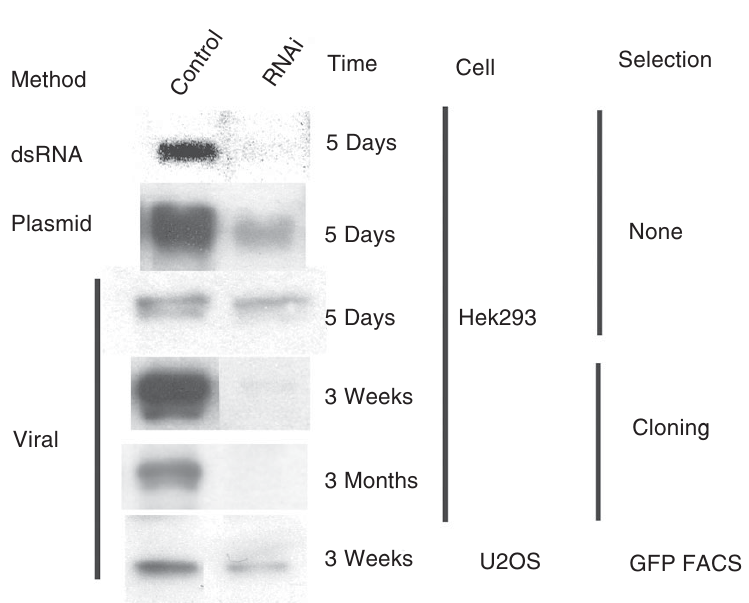
Figure 2. Small-interfering RNAs targeted against a kinase involved in mitosis were intro- duced into a mammalian cell culture either by direct transfection of plasmids or by means of viral transduction. An analysis of time, cell type and selection method is discussed in the text. dsRNA = double-stranded RNA; RNAi = RNA interference; GFP = green fluorescent protein; FACS = flow